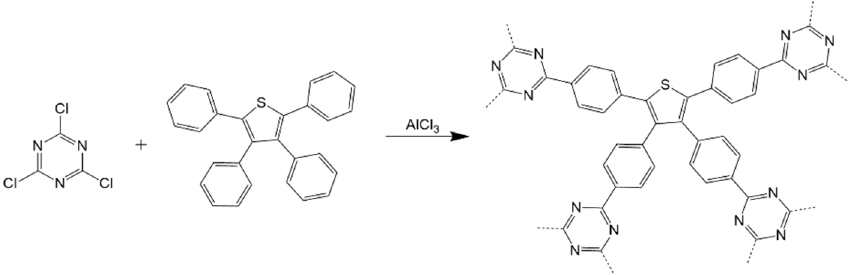
Figure 7. Polymerization of TTPT via Friedel–Crafts alkylation at 70 °C under reflux for 16 h